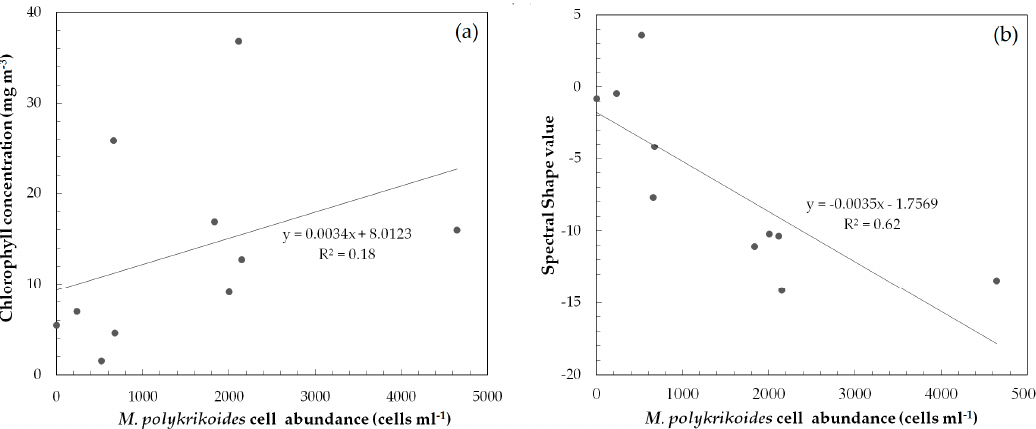
Figure 3. ( a ) Correlation between M. polykrikoides cell abundance and CHL, ( b ) correlation between M. polykrikoides cell abundance and Spectral Shape value.